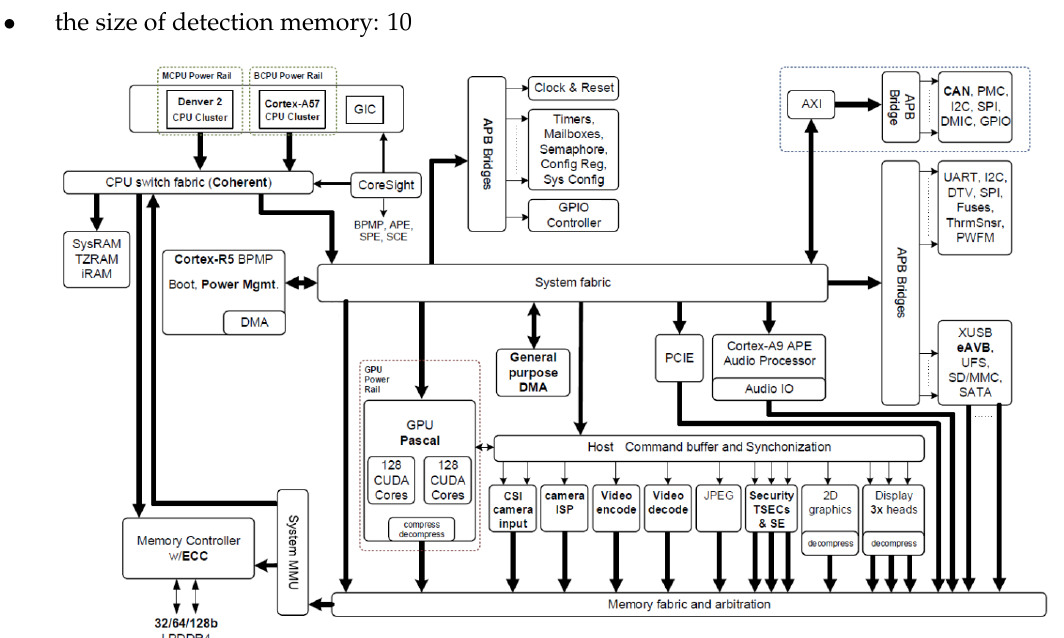
Figure 11. System architecture of the embedded board: The embedded board comes with 64-bit Quad-Core and Dual-Core CPU clusters, a GPU with 256 Compute Unified Device Architecture (CUDA) cores, and 8 GB 128-bit LPDDR4 RAM. The main purpose and advantage of this embedded board is used for embedded AI platform with speed and power efficiency [43], but to use a variety of features offered by the embedded board, a lot of software packages should be